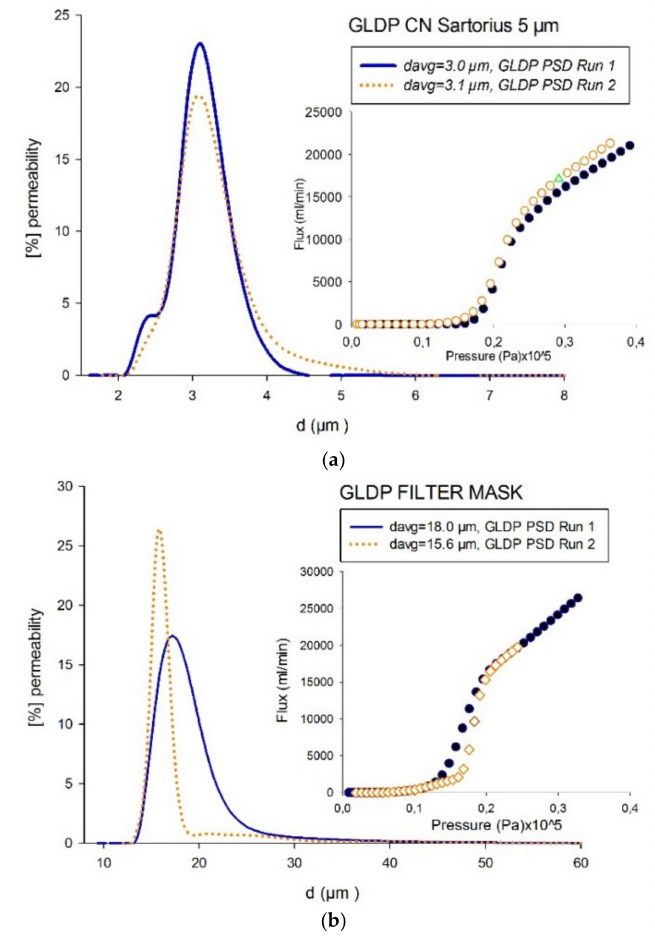
Figure 7. ( a ) Pore-size distributions (PSDs) of the NC membrane and ( b ) face mask as obtained using Gas Liquid Displacement Porometry